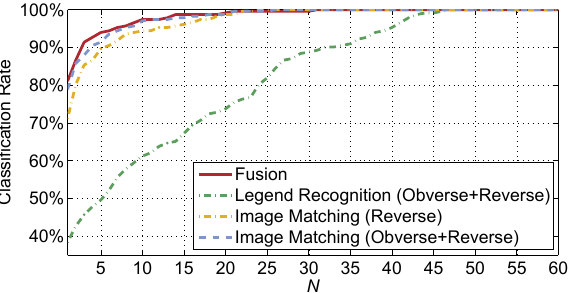
Figure 5: Overview of the fused classification method, which combines legend recognition with global image matching. Figure 6: Classification accuracy of legend recognition, image matching and hybrid coin classification for the top N